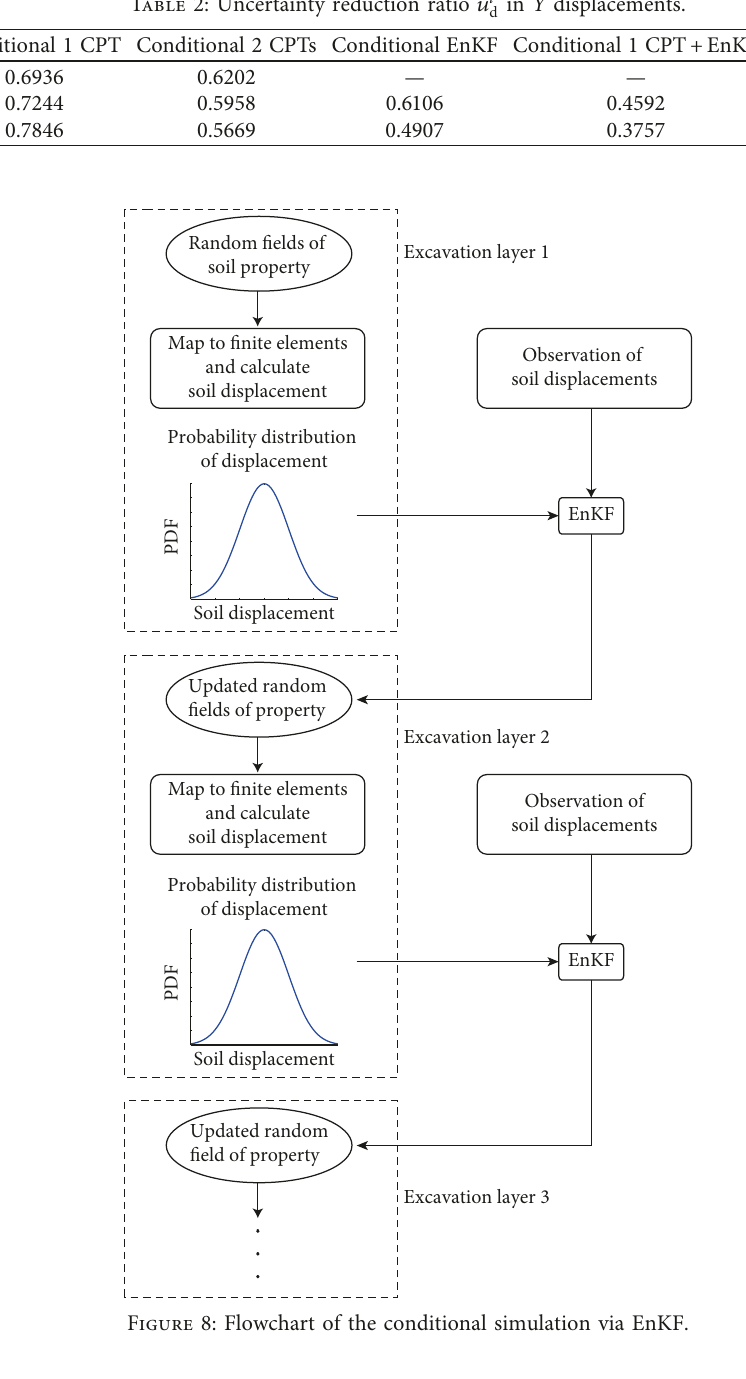
Table 1: Uncertainty reduction ratio u i